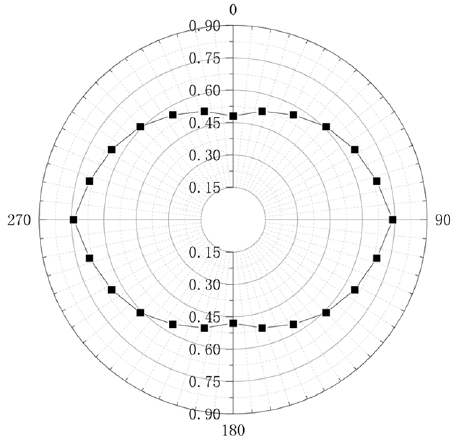
Figure 3. Annular distribution of frost heave force of rock mass ( unit: MPa).